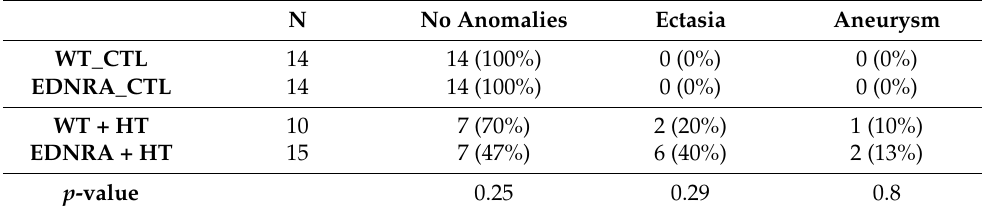
Table 2. Absolute and relative (in percentage) incidence of vascular anomalies.